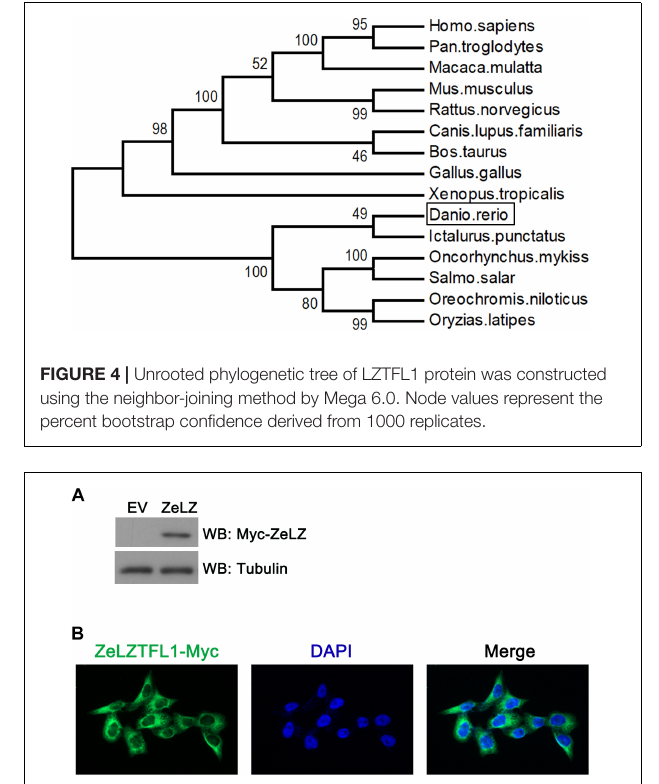
FIGURE 5 | (A) Myc-tagged zebrafish LZTFL1 plasmids were transfected into HeLa cells. At 48 h post-transfection, cells were lysed for Western blot